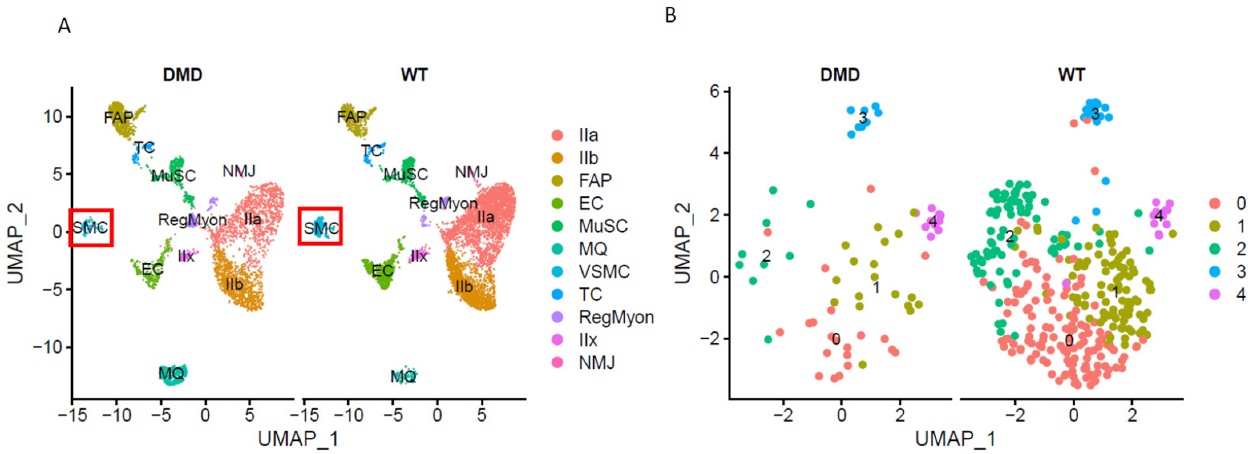
Figure 3. Single-nuclei RNA sequence (snRNA-seq) analyses. ( A ) Split view of UMAP plot representation of muscle-derived nuclei from the DMD mut and WT mouse samples. Each major cell type was represented with a different color. A red square indicates VSMC subsets from muscle nuclei. ( B ) Split view of UMAP plot representation of the VSMCs from DMD mut and WT mouse samples.